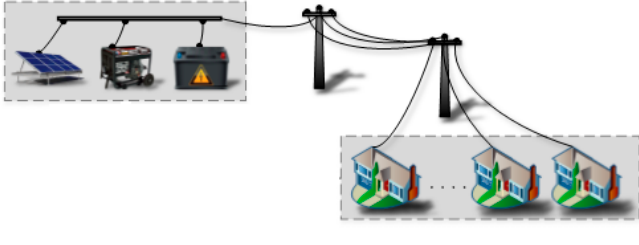
Figure 17. Islanded MG structure.